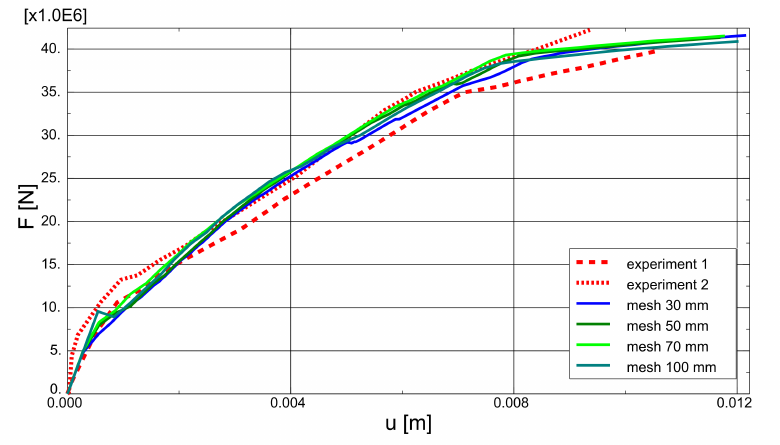
Figure 18. Beam failure in bending—mesh dependency study.